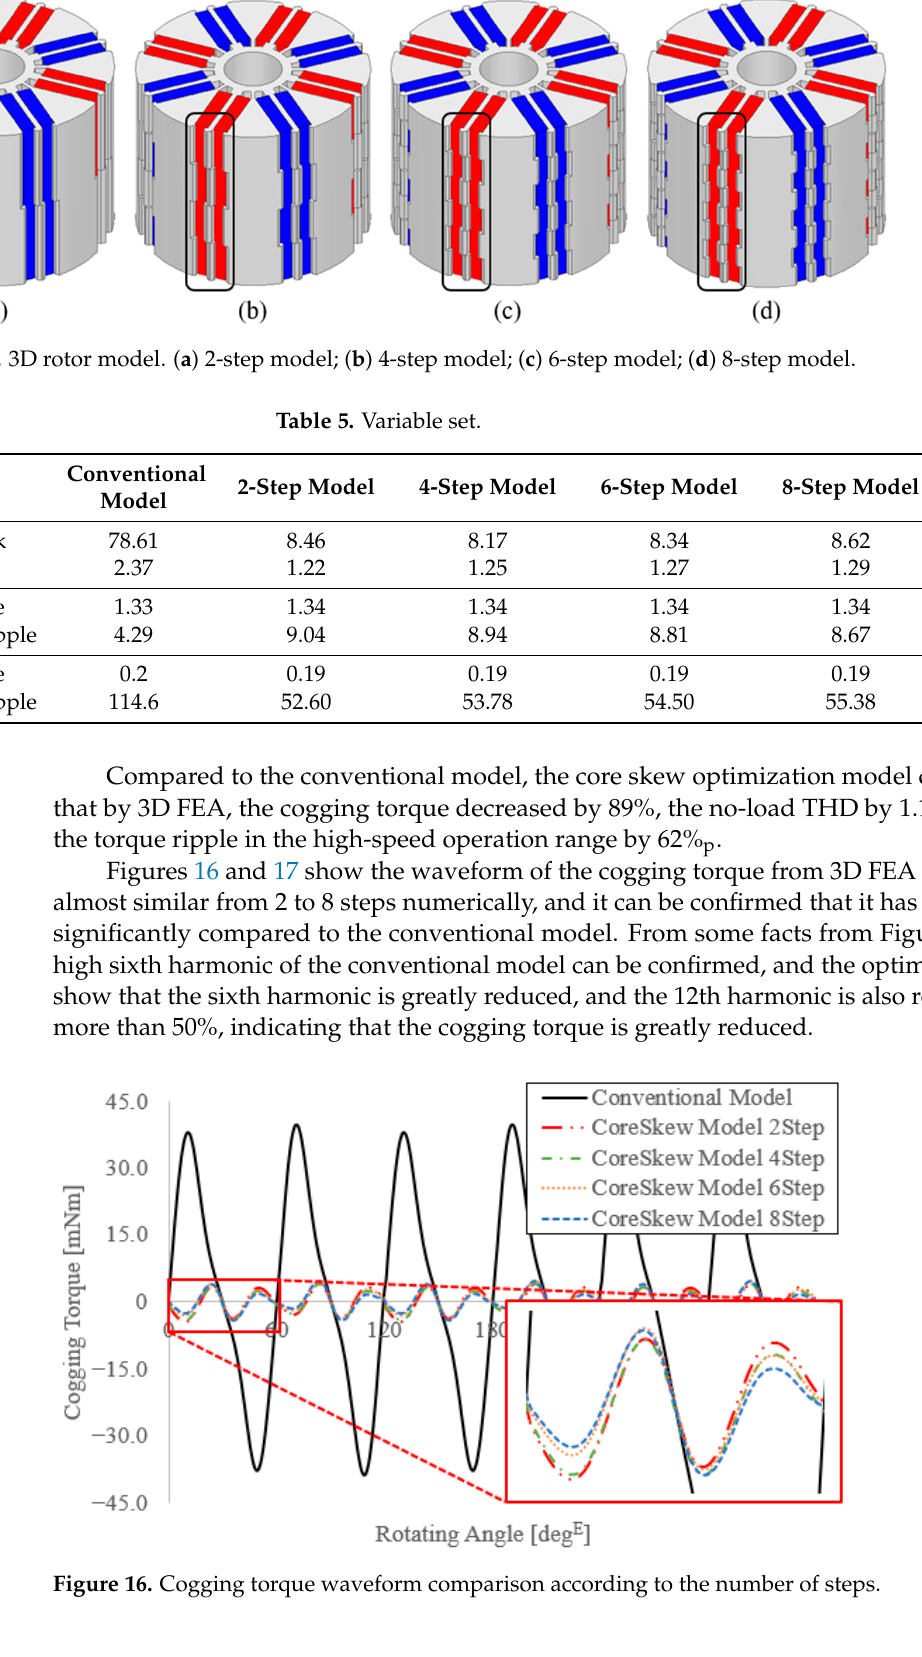
Figure 15. 3D rotor model. ( a ) 2-step model; ( b ) 4-step model; ( c ) 6-step model; ( d ) 8-step model.